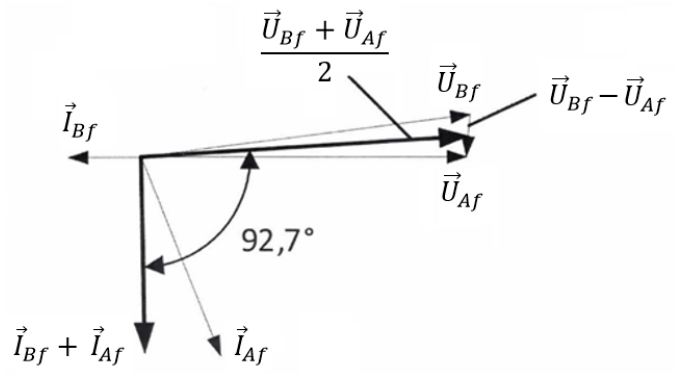
Figure 5. Vectors of the current and voltage phasors on OHLs.